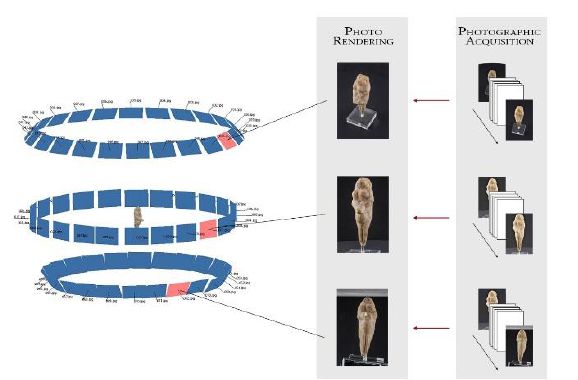
Figure 7. The pictures are taken with focus stacking, then are fused together and finally are used in Photoscan